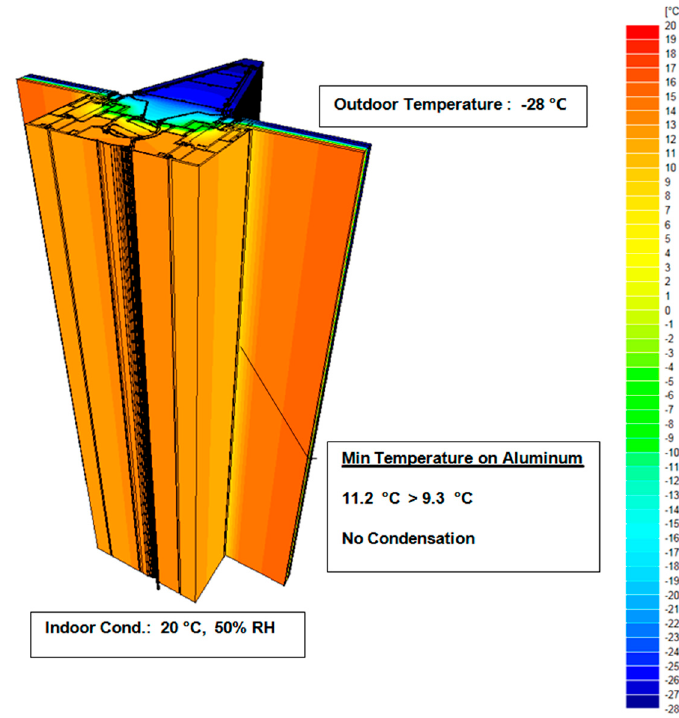
Figure 17. 3D steady-state heat transfer analysis of a vertical Trickle Vent [14].